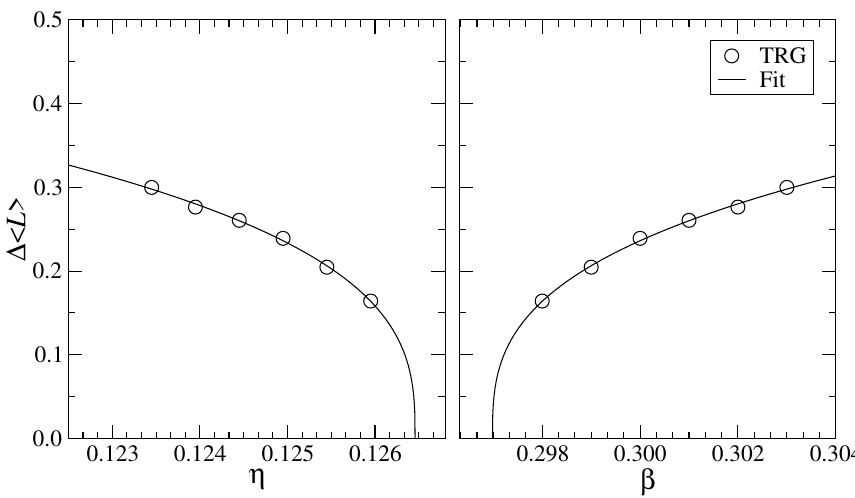
Figure 13 . (Left) Fit of ∆ h L i at µ = 2 as a function of η . (Right) Fit of ∆ h L i at µ = 2 as a function of β